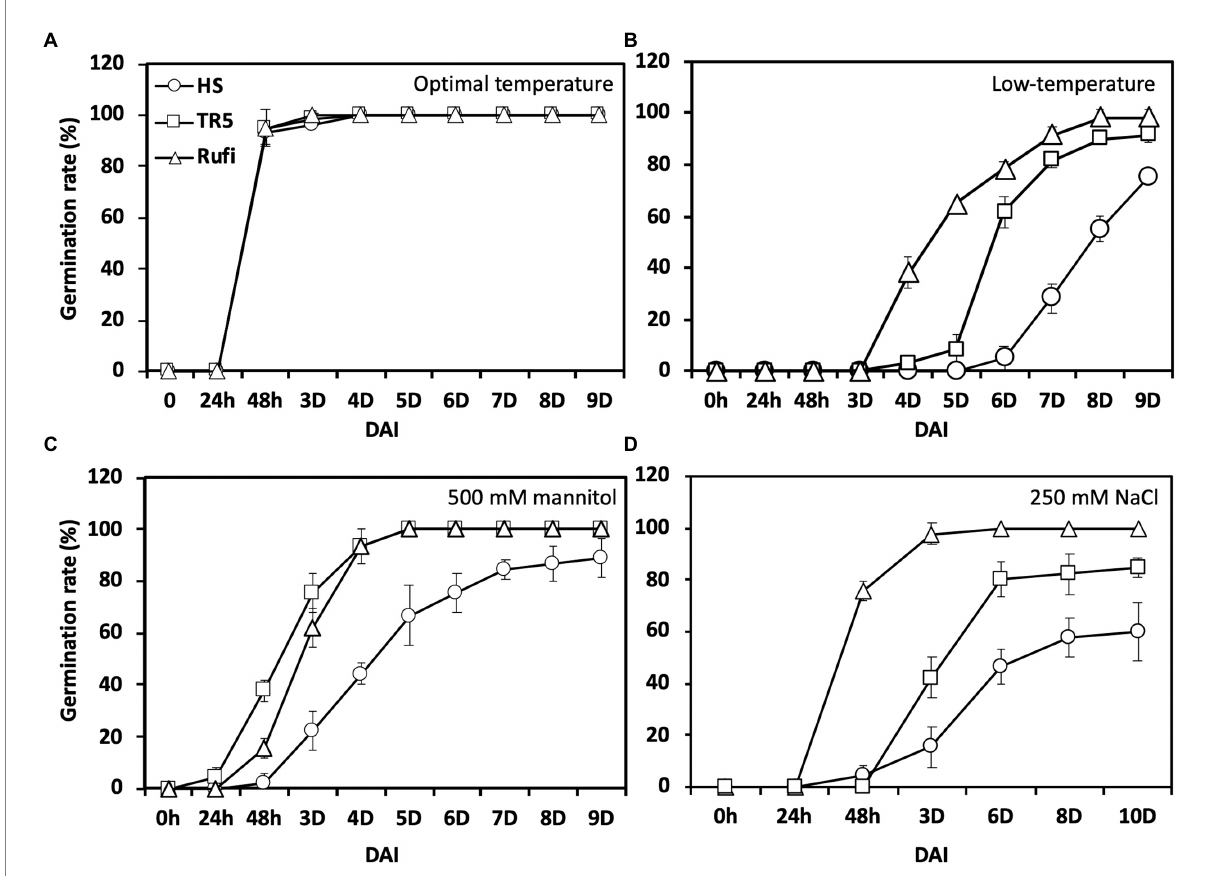
FIGURE 1 Seed germination under low-temperature and abiotic stress conditions using Hwaseong, Oryza rufipogon , and TR5. (A) Germination rate under optimal temperature (28 ° C); (B) Germination rate under low-temperature (13 ° C); (C) Germination rate under high osmotic stress (500 mM mannitol) at 28 ° C; and (D) Germination rate under high salinity stress (250 mM NaCl) at 28 ° C. Triangle, square, and circle indicate O. rufipogon , TR5, and Hwaseong, respectively. Data are presented as mean ± SD ( n = 3). DAI, days after